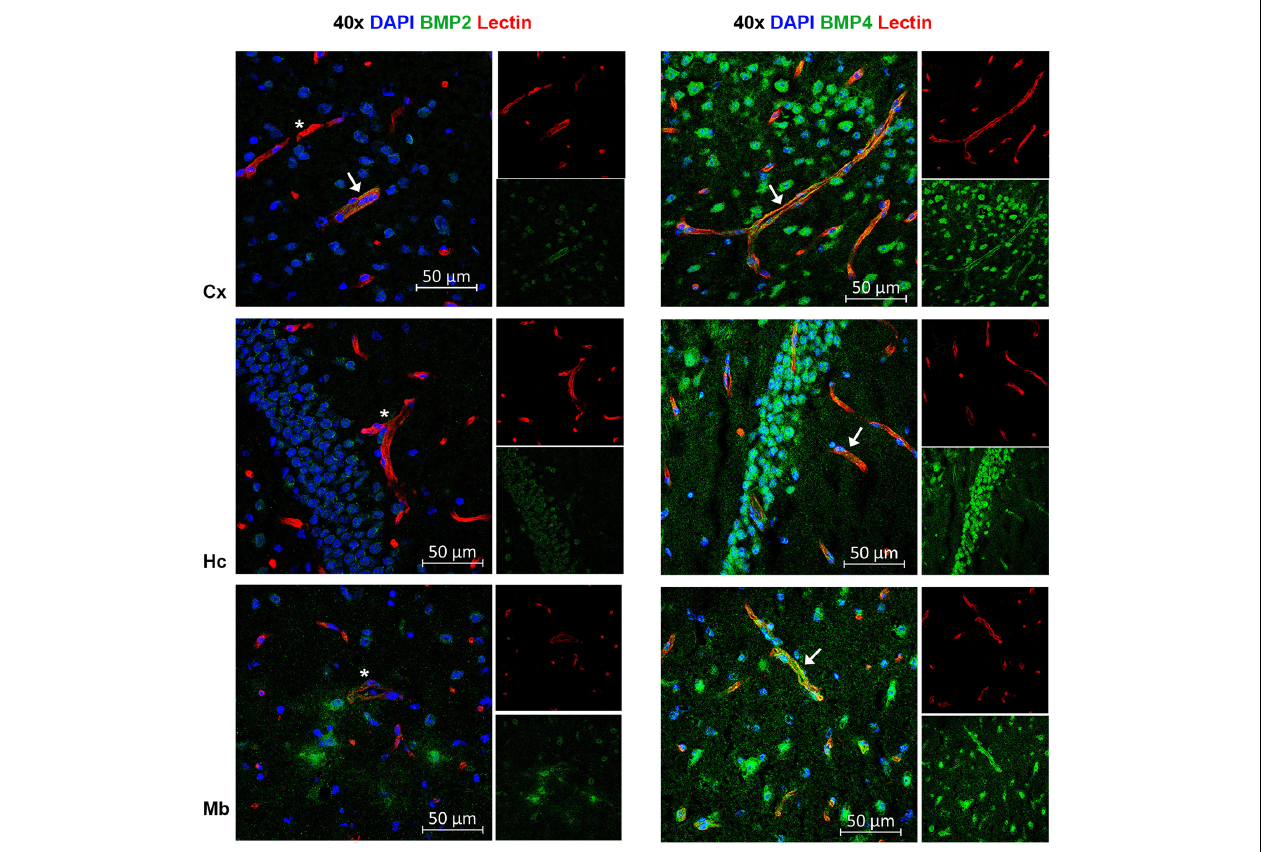
FIGURE 7 | A subpopulation of endothelial cells express BMP2 and BMP4. Confocal images showing BMP2 and BMP4 (green) and the endothelial cell marker tomato lectin (red). Nuclear staining is shown in blue. In some vessels in neocortex, BMP2 staining is observed (arrow), while most vessels are BMP2 negative (asterisks) in neocortex, hippocampus and midbrain. In contrast, widespread BMP4 staining is observed in vessels in cortex, hippocampus and midbrain (arrow). Cx, neocortex; Hc CA, hippocampus CA1 region; Mb, midbrain. Scale bars = 50 µ